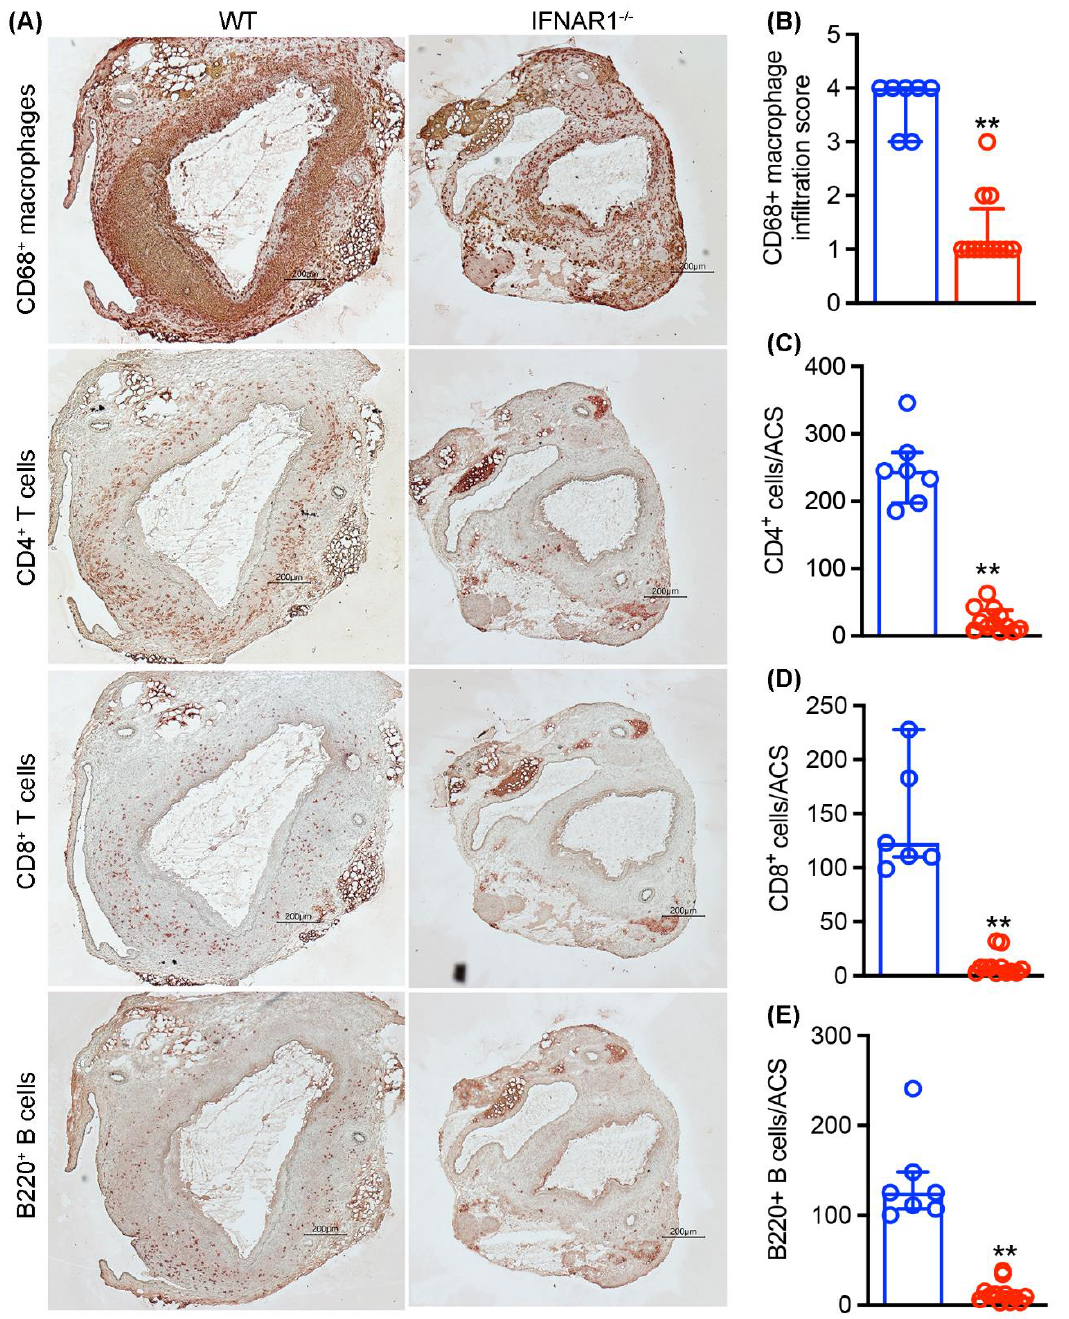
Figure 5. Type I IFN receptor subunit 1 deficiency reduces aortic leukocyte accumulation in ex- perimental AAAs. Aortic frozen sections from elastase-infused wild type (WT, n = 7) and type 1 IFN receptor subunit 1-deficient (IFNAR1 −/− , n = 12) mice were stained with monoclonal antibodies against CD68 for macrophages, CD4 for CD4 + T cells, CD8 for CD8 + T cells and B220 for B cells. Macrophage accumulation was scored from I (mild) to IV (severe). Other leukocytes were enumerated as positively stained cells/aortic cross-section (ACS). ( A ) Representative images for macrophages, CD4 + and CD8 + T cells and B cells in elastase-infused WT and IFNAR1 −/− mice. ( B – E ) Quantification (median and interquartile) of mural macrophages, CD4 + T cells, CD8 + T cells and B cells between groups. Nonparametric Mann – Whitney test, ** p < 0.01 compared to WT mice. Scale bar: 200 μm.